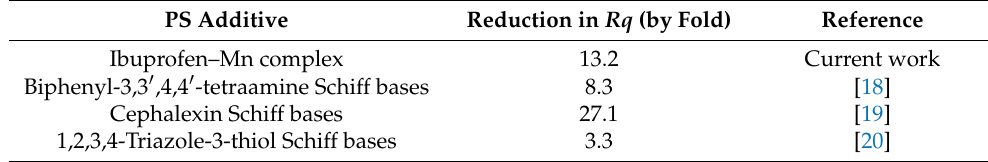
Table 4. The decrease in the Rq (by fold) for the irradiated PS blended with different additives. PS Additive Reduction in Rq (by Fold) Reference